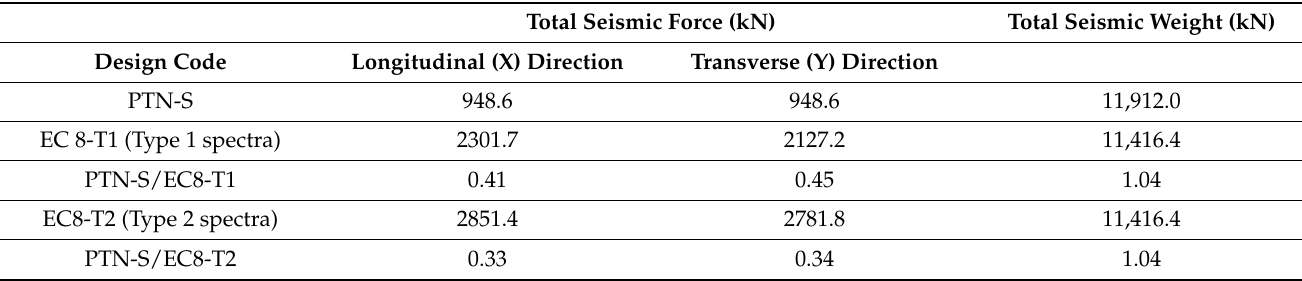
Table 6. Total horizontal seismic force (multiplied by applicable partial safety factors). Total Seismic Force (kN) Total Seismic Weight